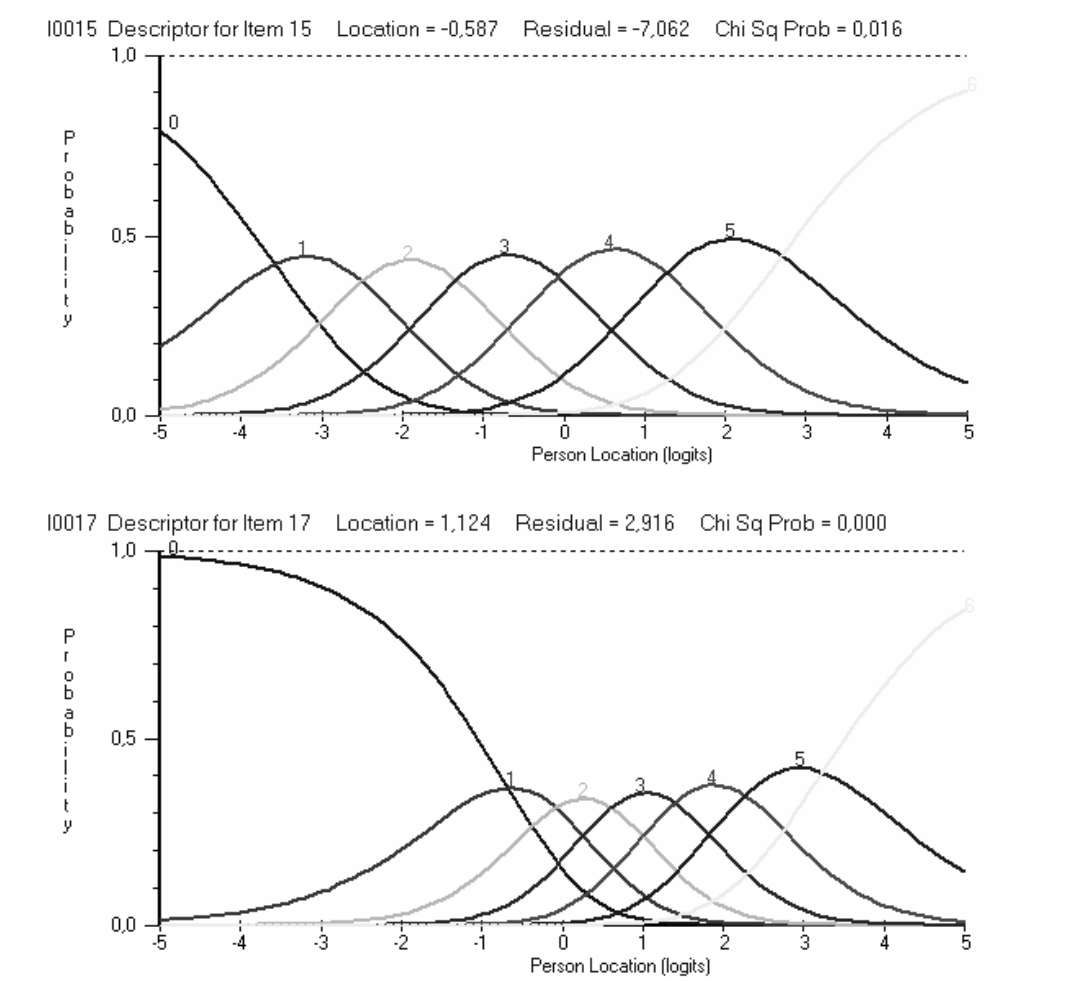
Figura 3 – Probability Category Curves (PCC) per gli item I0015 e